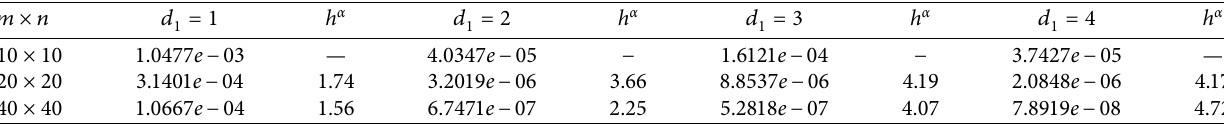
� 9 for Example 1. 2